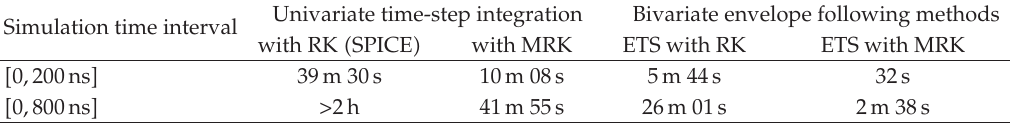
Table 1: Computation times simulation of the RF polar transmitter PA depicted in Figure 6. Univariate time-step Simulation time interval